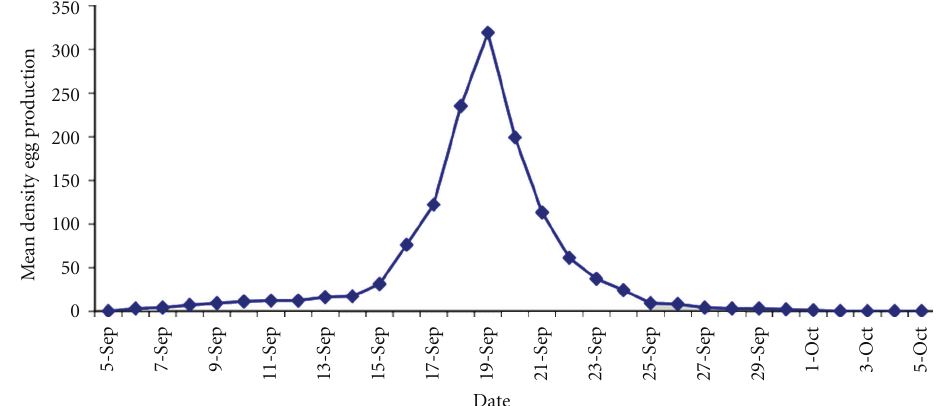
Figure 3: Mean daily egg production for eight Diana fritillary females collected from western North Carolina, fall 2007.